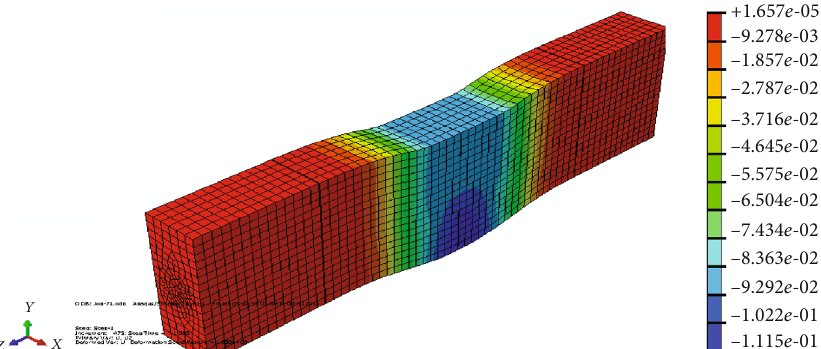
Figure 8: Clouds of soil deformation along pipeline.